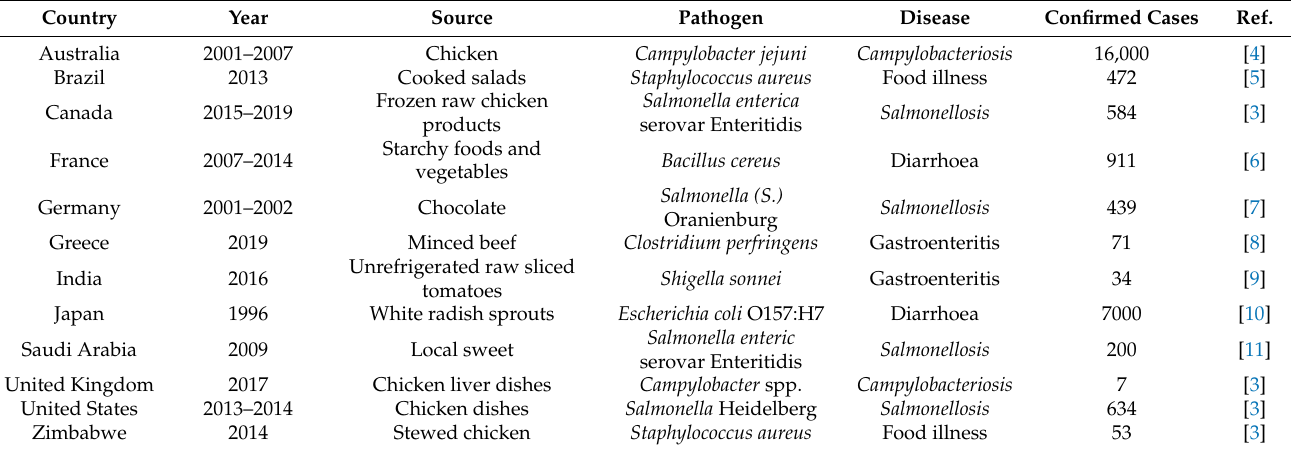
Table 1. Disease outbreaks due to foodborne